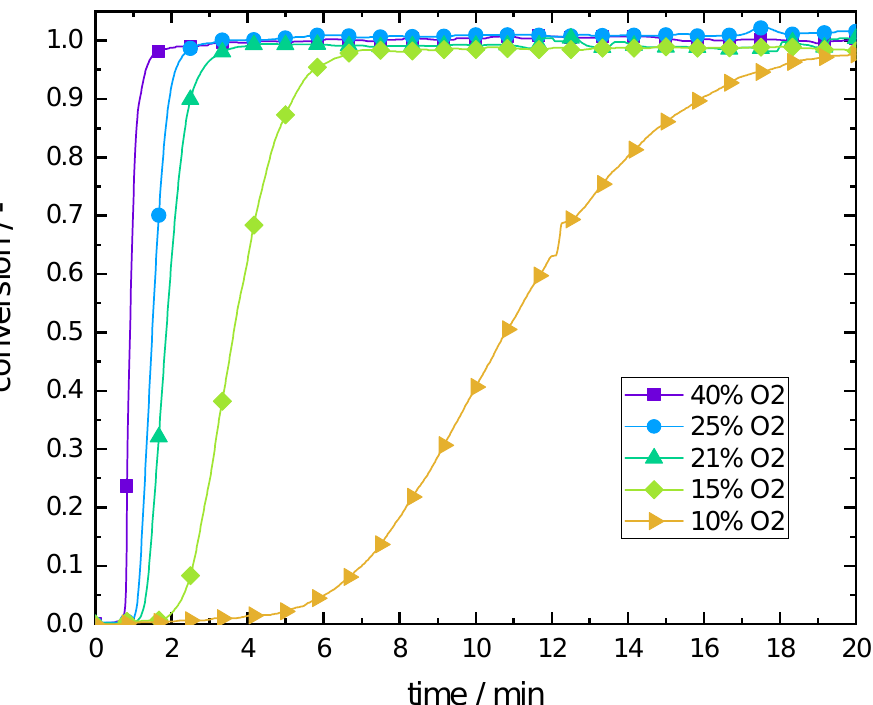
Figure 5. Isothermal oxidation of manganese–iron oxide particles with varying oxygen partial pressure in a thermogravimetric analyzer at 850 ◦